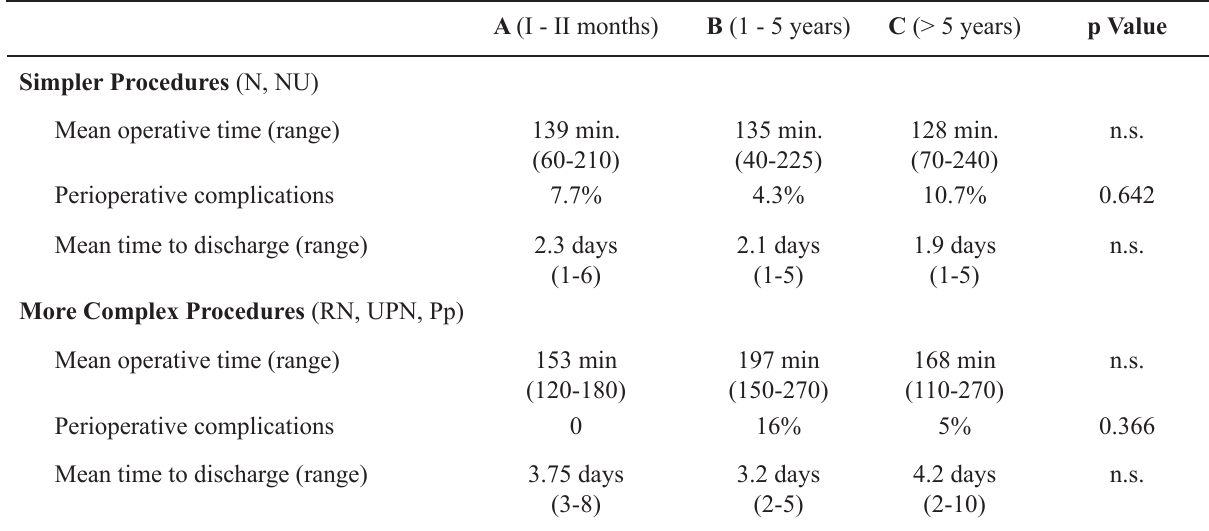
Table 4 – Operative and postoperative data for simpler and more complex procedures in each age